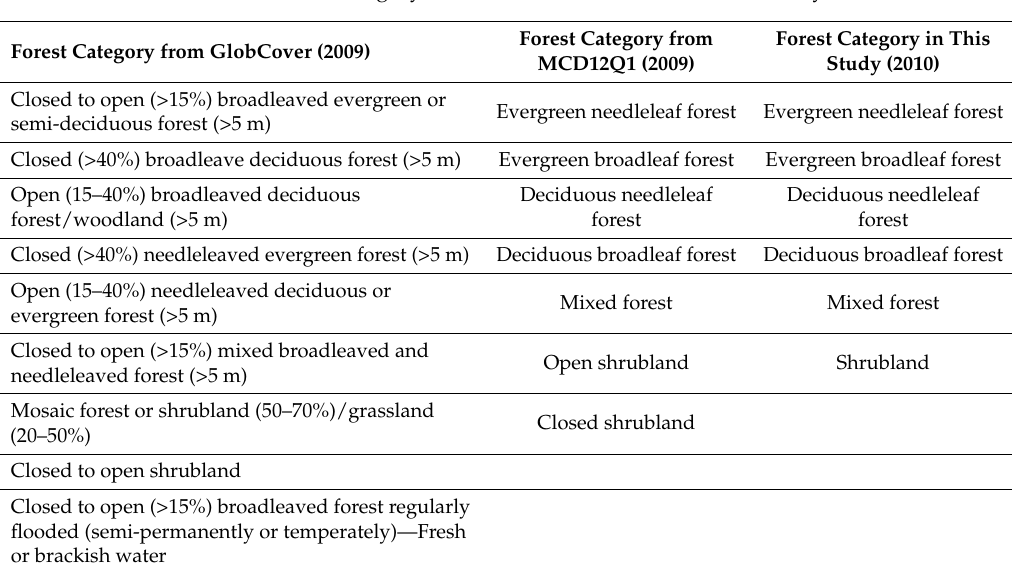
Table 3. Forest category of GlobCover, MCD12Q1 and this